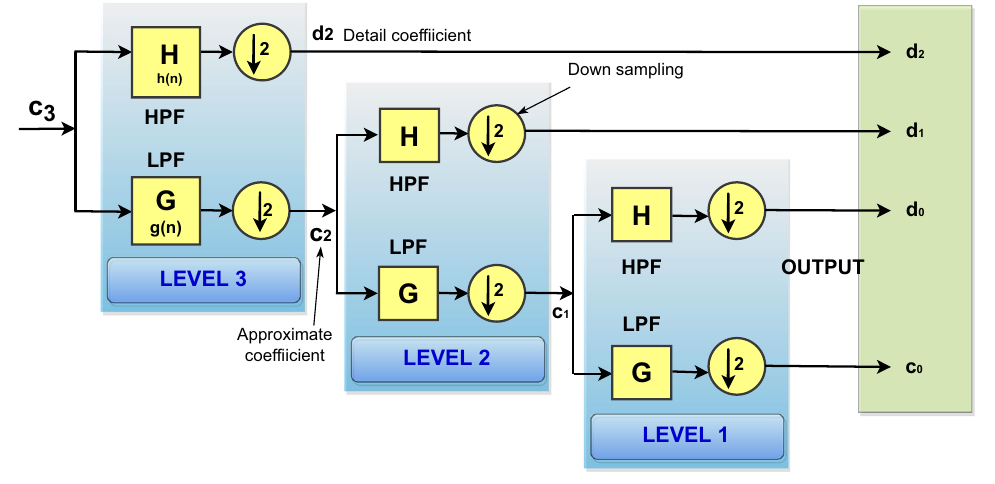
Figure 1. Representation of three-level discrete wavelet